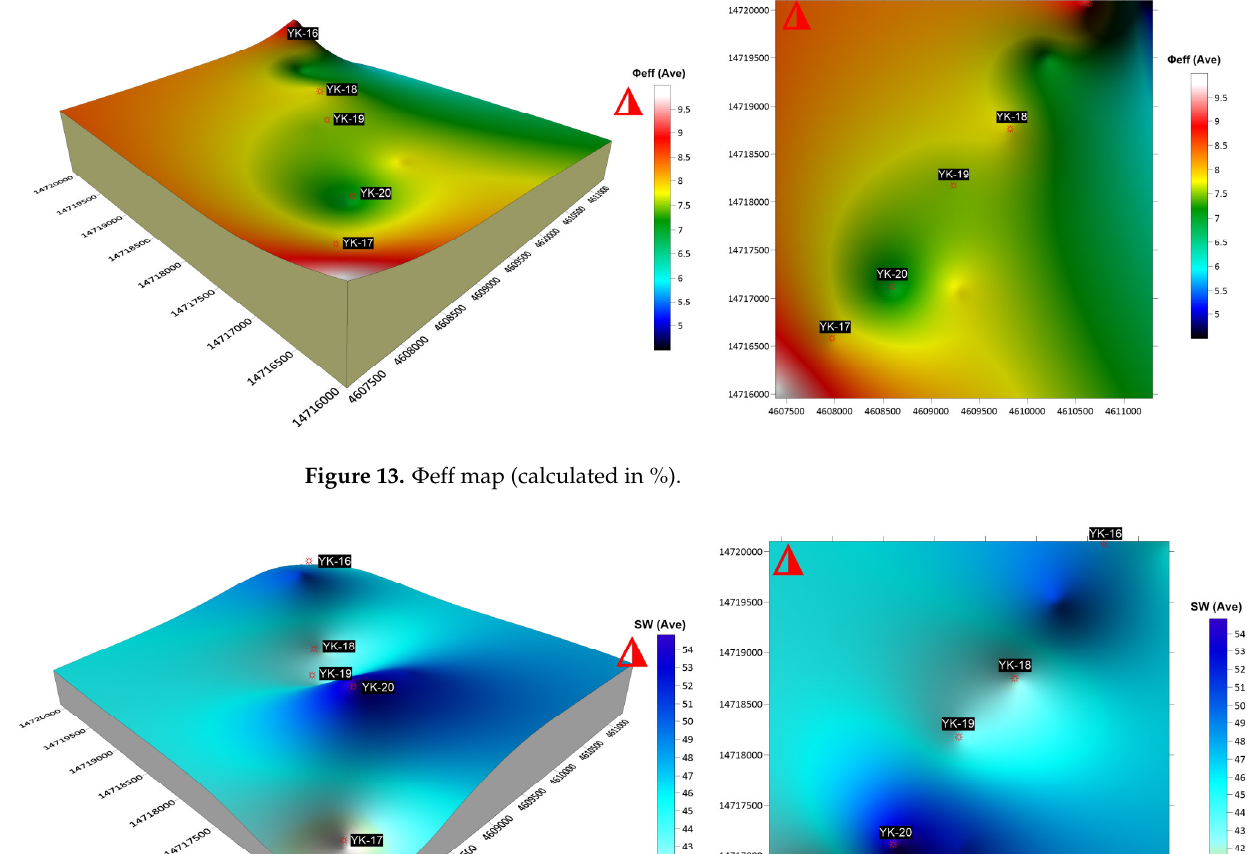
Figure 12. Shale volume variation map (calculated in %).